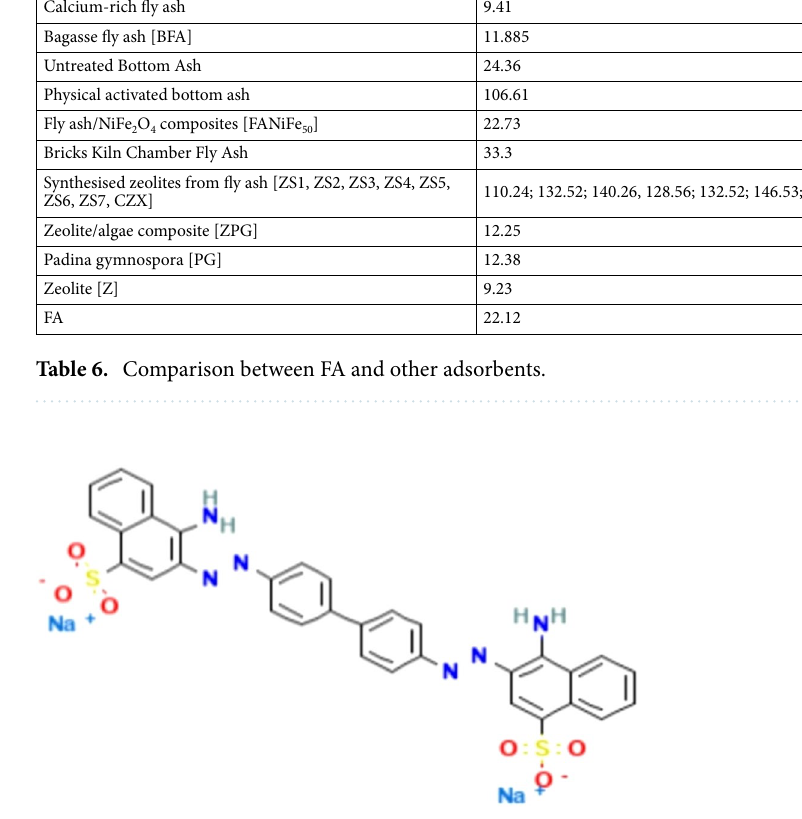
Figure 24. Structure of Congo Red